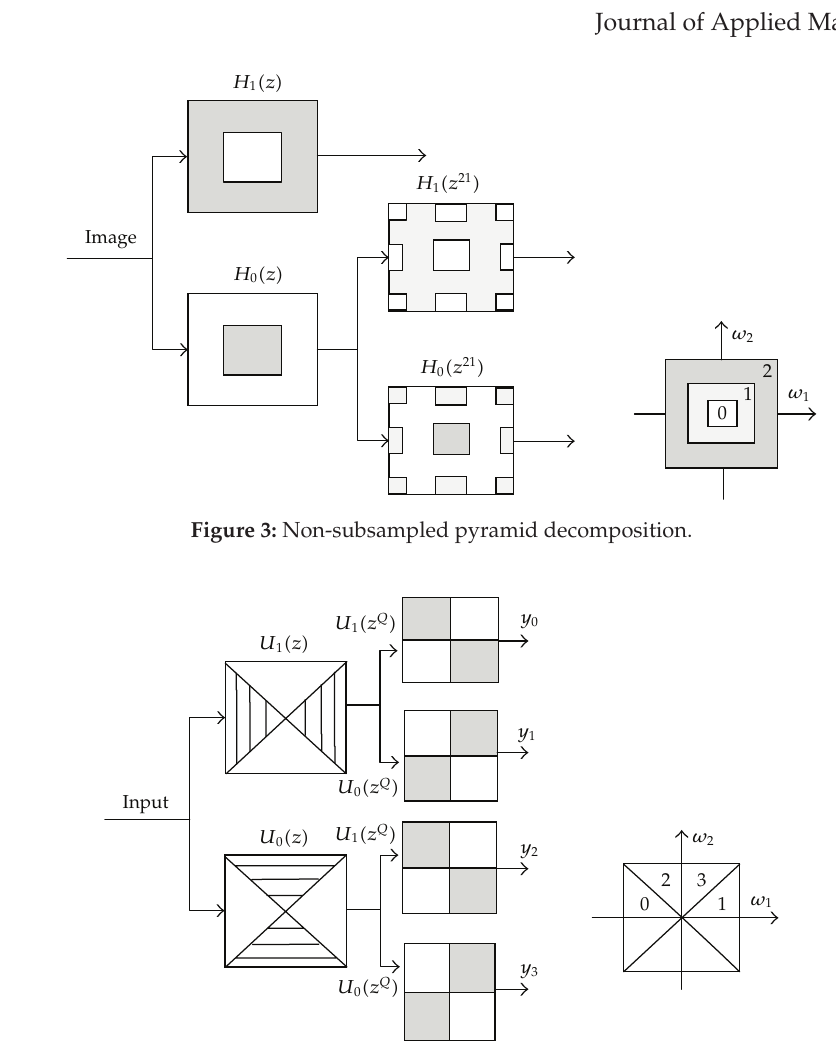
Figure 4: Nonsubsampled directional filter